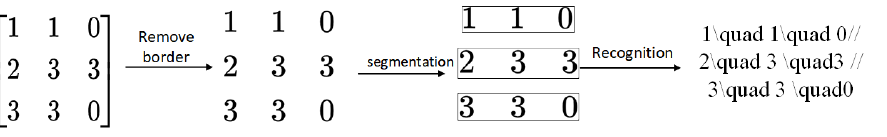
Figure 9. Segmentation and identification